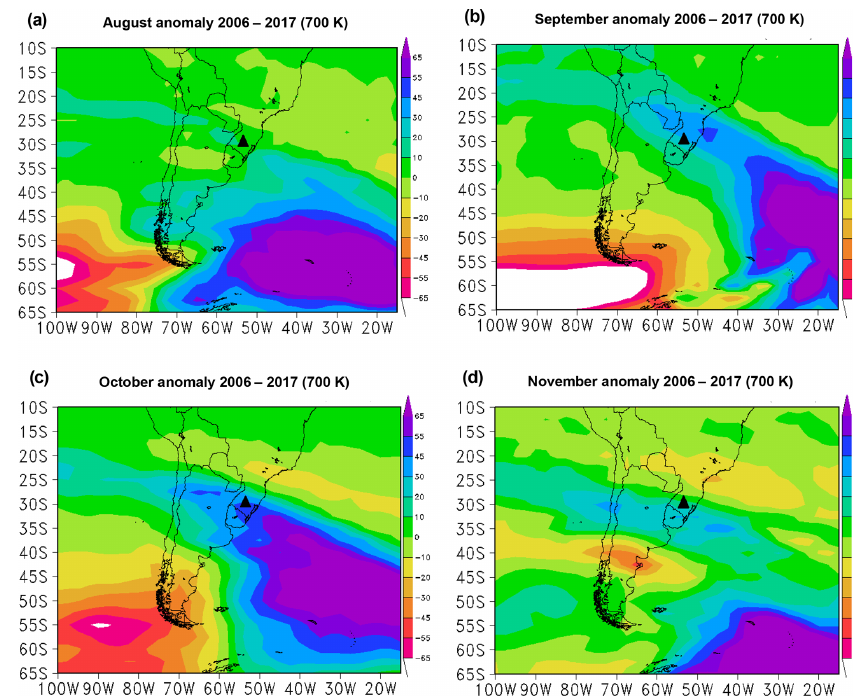
Figure 5. Monthly PV anomaly fields for the period from 2006 to 2017, at the isentropic level of 700K potential temperature.